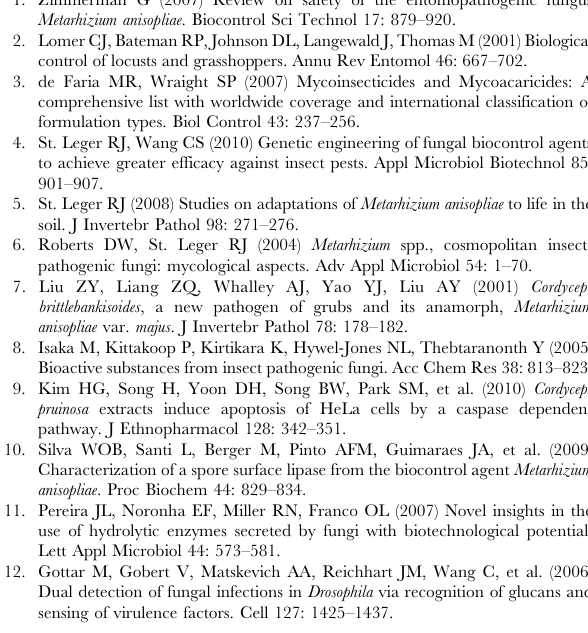
Table S16 Classification of conserved domains retained in the pseudogenes of Metarhizium anisopliae and M. acridum .